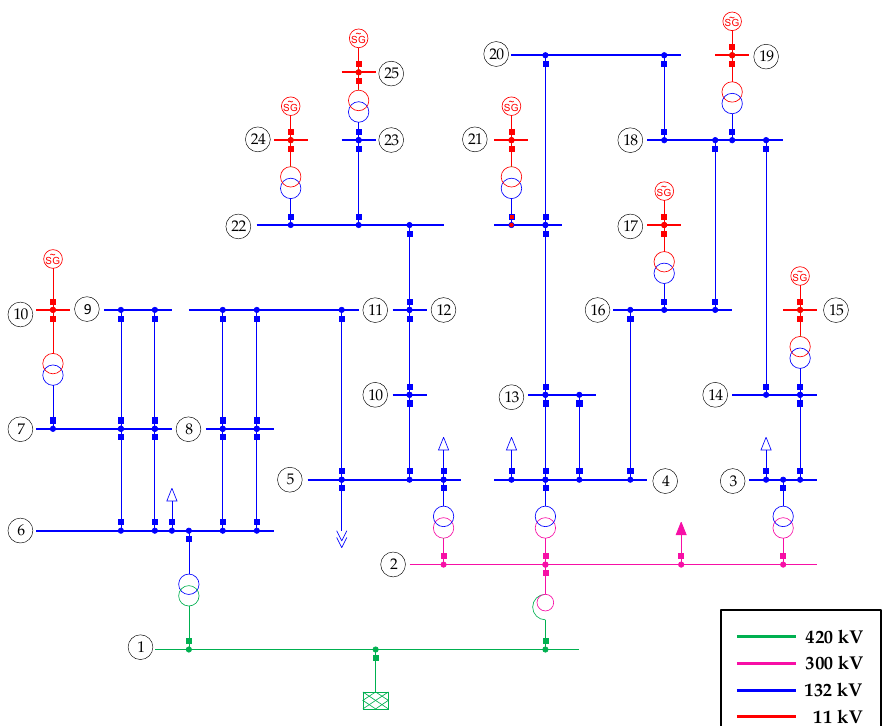
Figure 4. One-line diagram of the Vestfold and Telemark distribution network [2]. Table 1. Study cases and parameters of the reactive power control mechanisms enabled at the